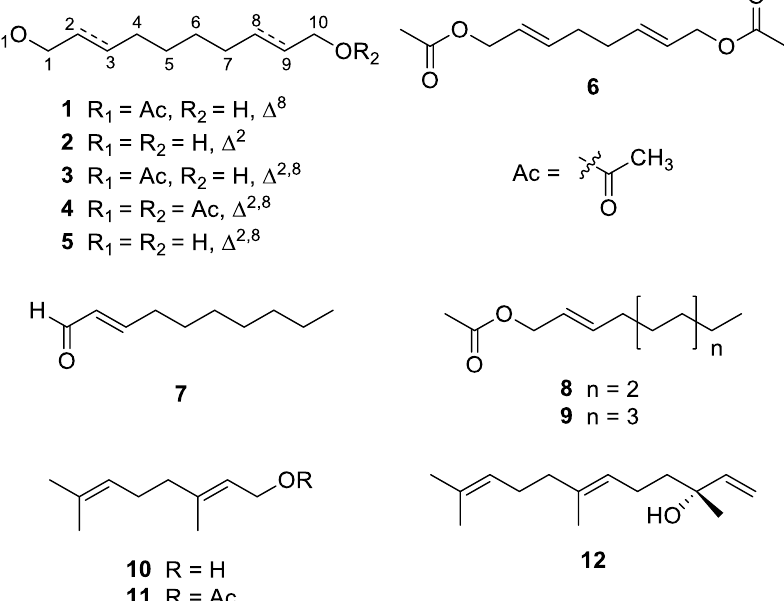
Figure 1. Chemical structures of compounds 1 – 12 isolated from the fruits of A . tsao-ko . Table 1. 1 H and 13 C NMR assignments for compounds 1 and 3 ( δ in ppm, CDCl 3 , 500 and 125